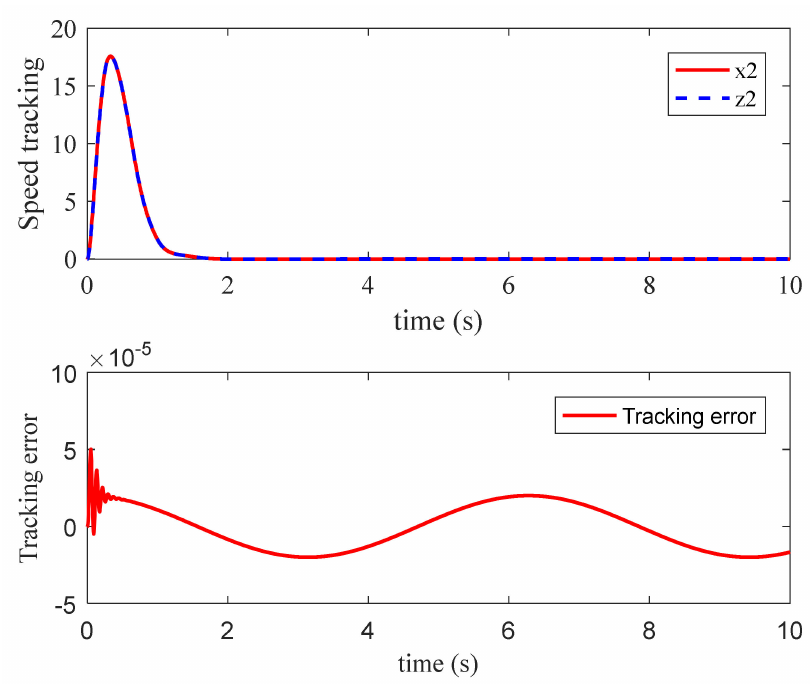
Figure 6. Time response and tracking error of observer for speed tracking. ( x 2 and z 2 represent the practical speed state of the system and the corresponding state estimated by the observer,